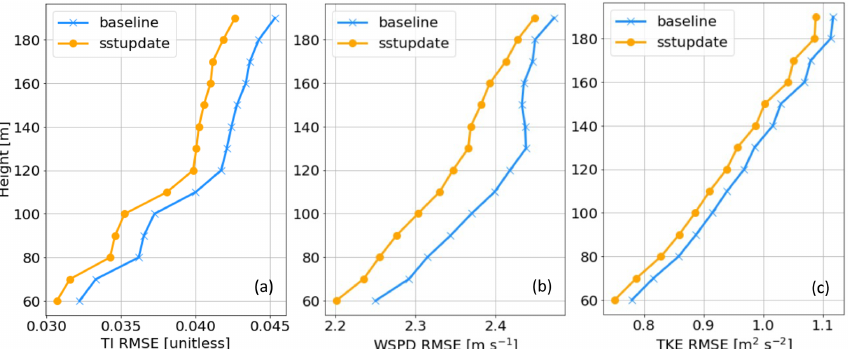
Figure 6. RMSE profiles of (a) TI, (b) WSPD, and (c) TKE for baseline (blue) and sstupdate (orange) simulations between 60 and 190m.